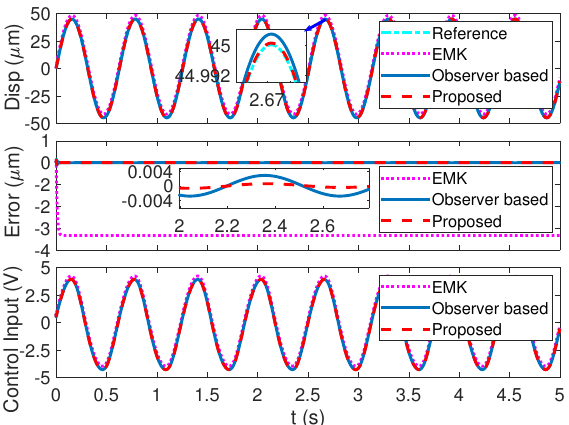
Figure 7. Simulation results of the three control methods (10